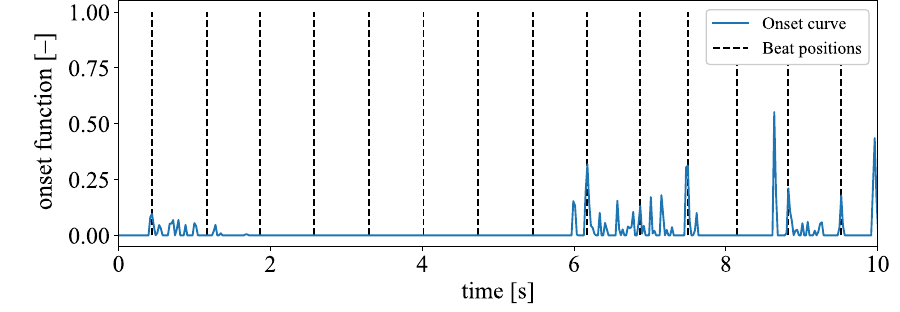
Figure 9. Estimated beat positions by the dynamic programming